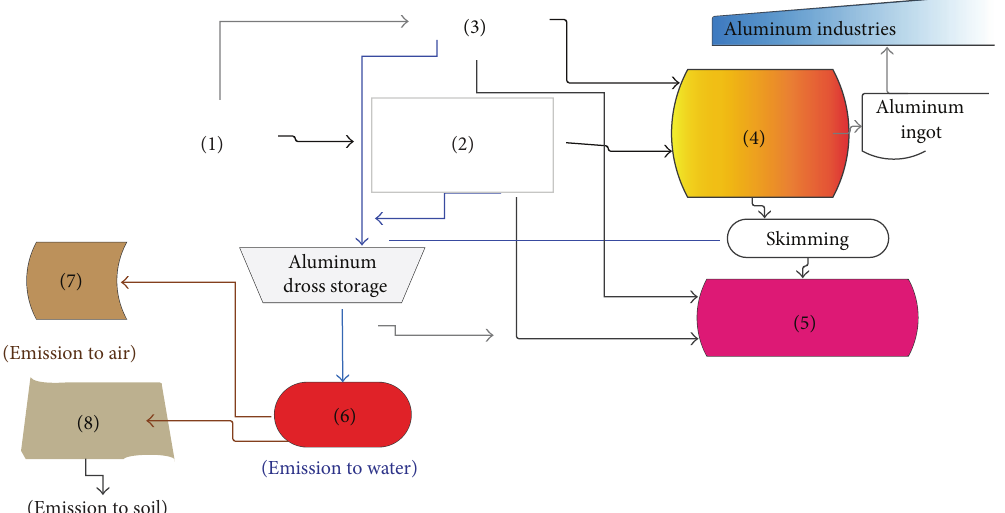
Figure 4: Flowchart of the secondary aluminum remelting in proposed